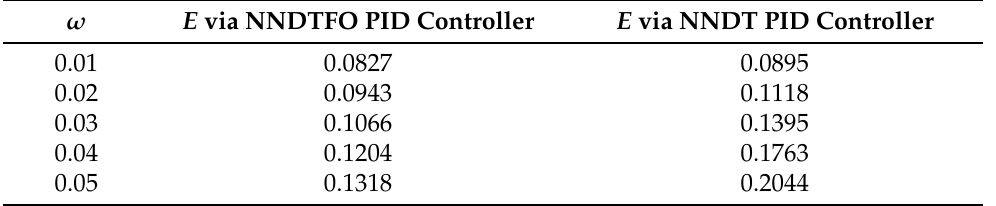
Table 1. Index E for different parameters ω with A = 0.1 via two types of controller.